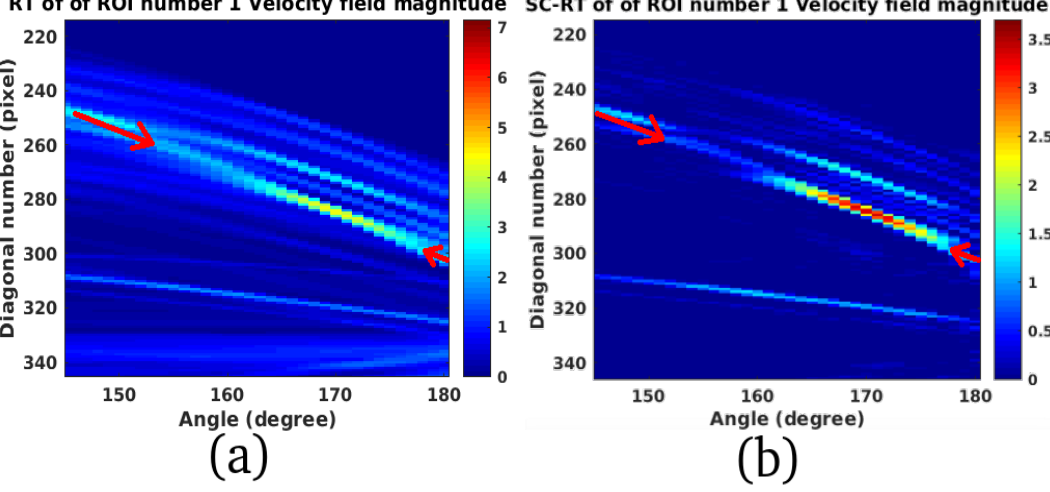
Figure 12. ( a ): RT of the displacement ROI (Particular 4 of Figure 9). ( b ): Sparse component of the RT of the displacement ROI (Particular 3 of Figure 9).